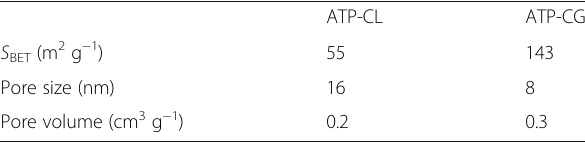
Table 2 Textural properties of